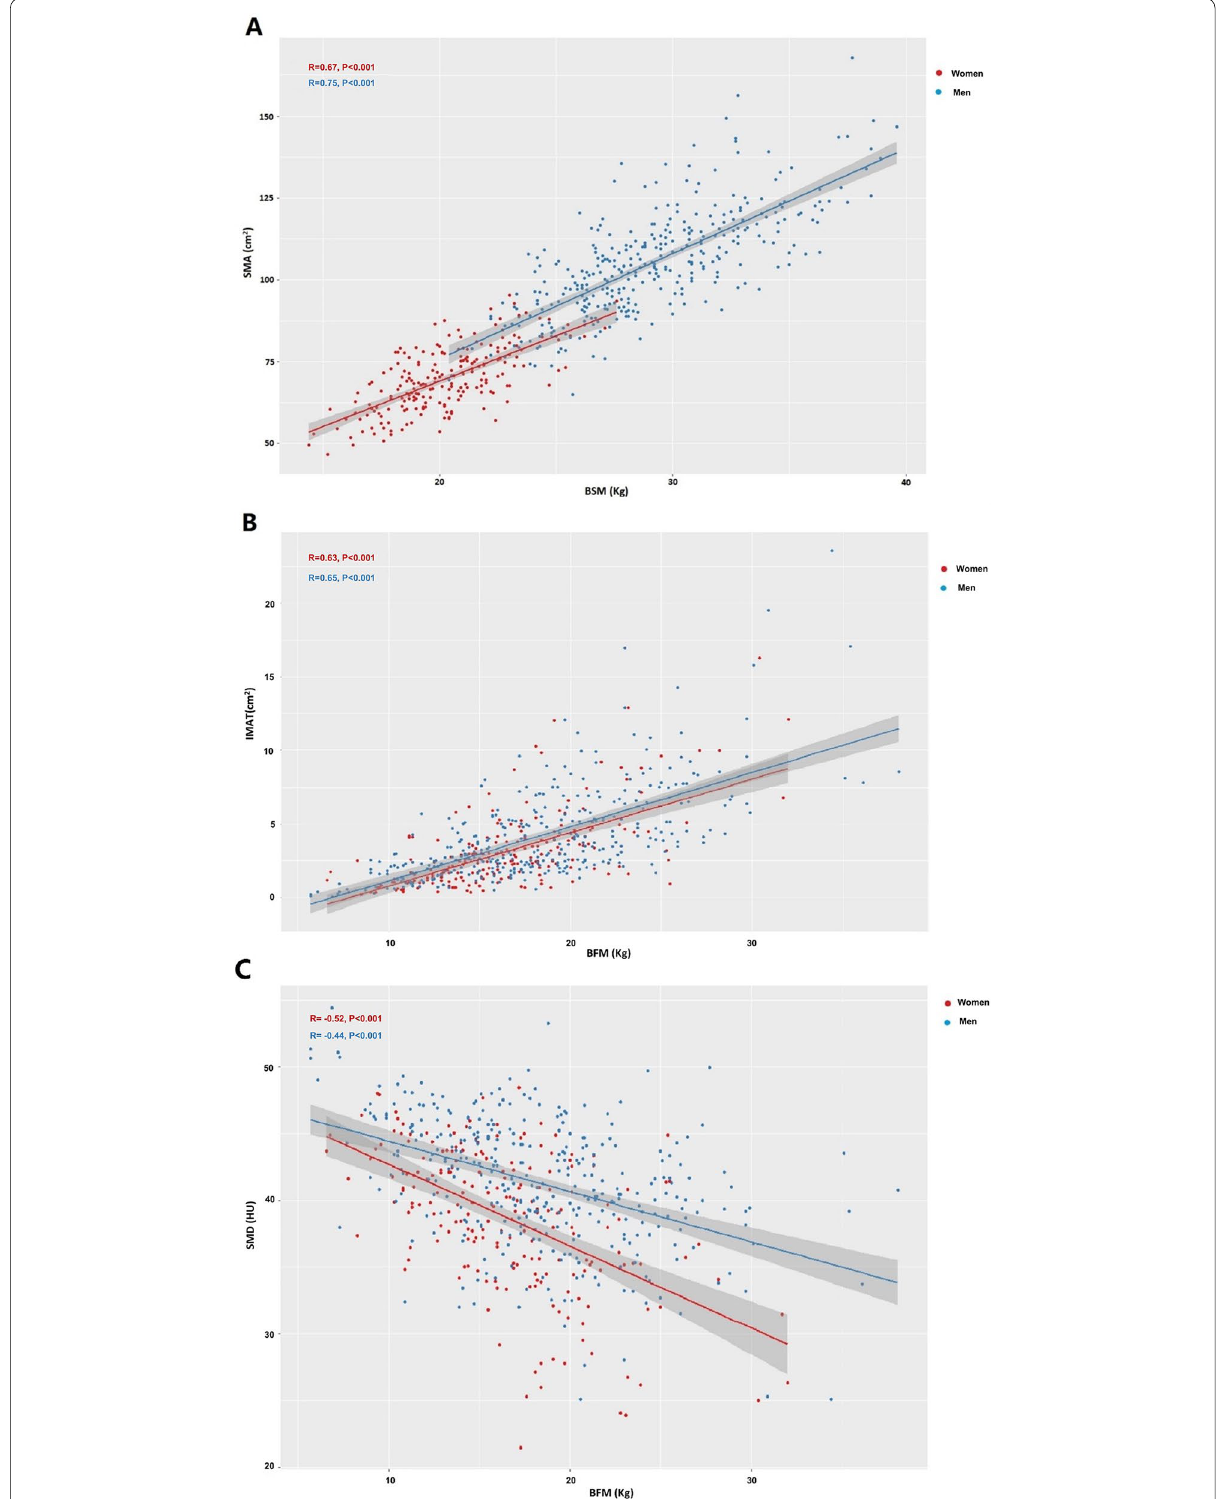
Fig. 4 The scatter plots and linear regression lines of SMA with BSM ( A ), IMAT with BFM ( B ), and SMD with BFM ( C ) in men and